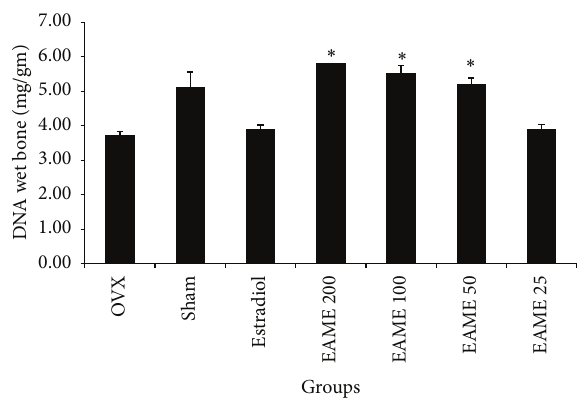
Figure 4: Effect of oral administration of EAME on DNA content of the metaphysis of the femur of ovariectomised mice. Mice were orallyadministeredwiththeextractsforaperiodof30days.Animals were sacrificed after the termination of extract administration and femur was harvested. The metaphyseal tissue of the femur was obtained and homogenised in alkaline condition. The supernatant collected after centrifugation was measured for its DNA content. Each value is the mean ± SEM. ∗ 𝑃 < 0.05 , compared with the OVX control value.